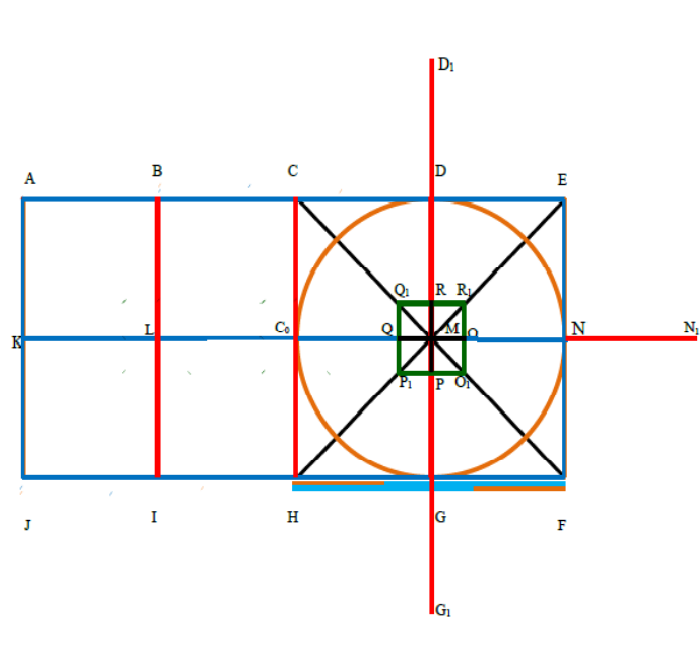
Figure 4. Golden section of